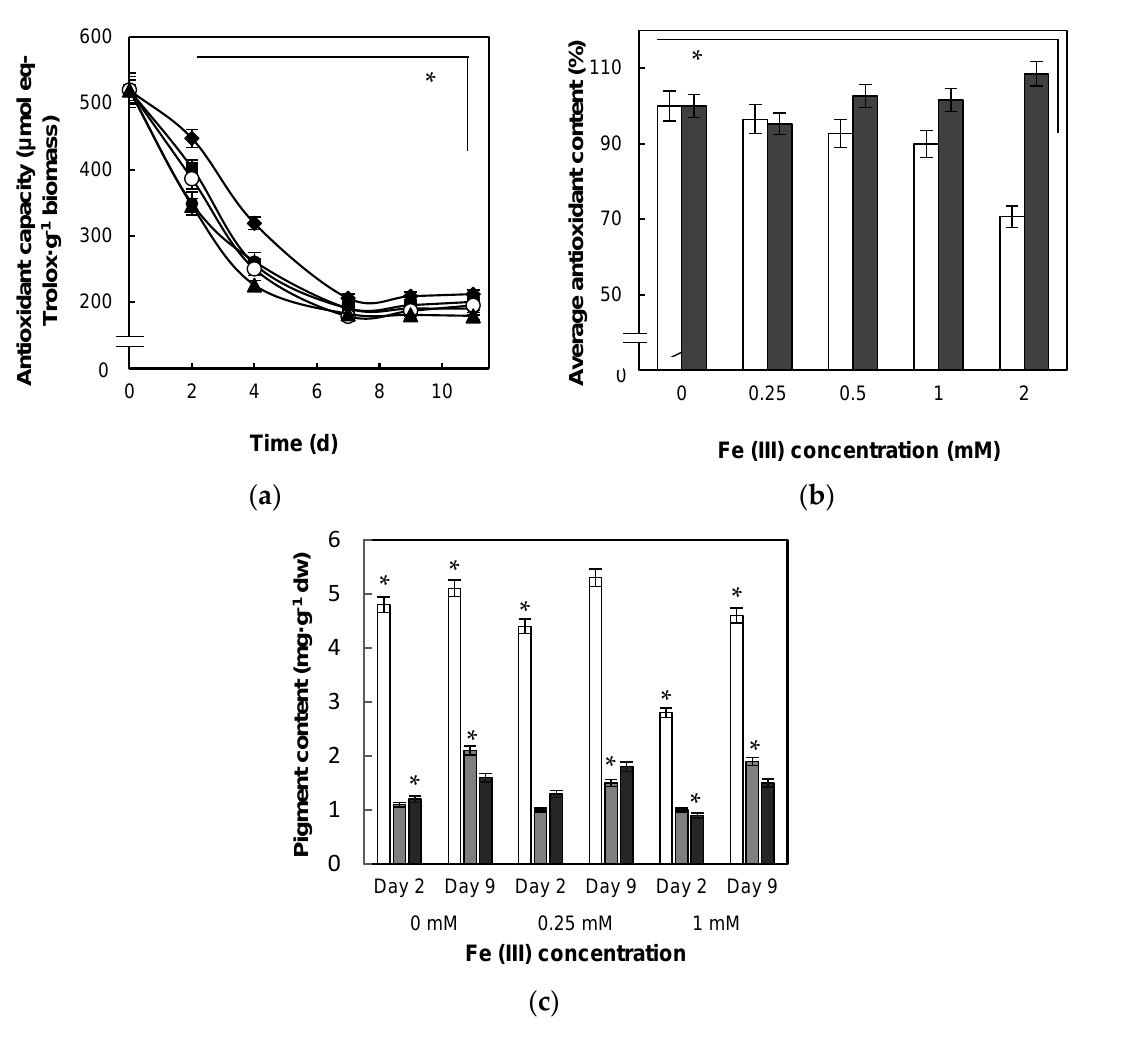
Figure 5. Effect of Fe (III) concentration on the non-enzymatic antioxidant response of C. onubensis cultures. ( a ) Symbols for Fe (III) concentration: 0 (- ◆ -), 0.25 (- ◼ -), 0.5 (- ● -), 1 (- ○ -) and 2 (- ▲ -) mM; ( b ) Average antioxidant content between days 2 and 9 of cultivation: polyphenols (empty bar) and flavonoids (black bar). In total, 100% of polyphenols and flavonoids corresponds to an average content of 17.50 and 4.75 mg·g −1 biomass, respectively; ( c ) Pigment content: lutein (empty bar), neoxanthin (grey bar) and beta-carotene (black bar) for day 2 and 9 of cultivation. (*) Represents the significant differences of all treatments with respect to the control with 95% confidence.